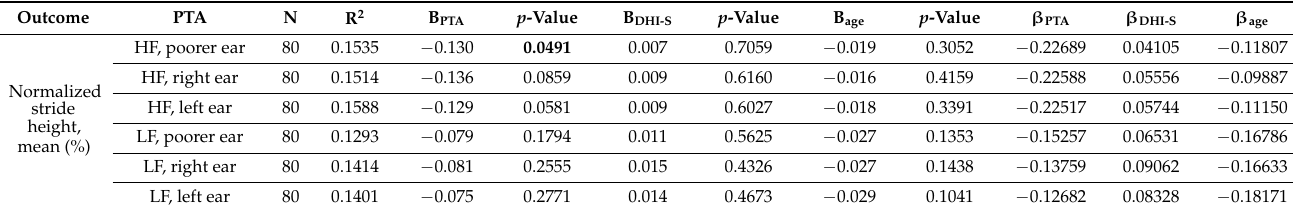
Table 4. Multiple regression models for the outcome normalized stride height (%) for 10 dB increases in different hearing